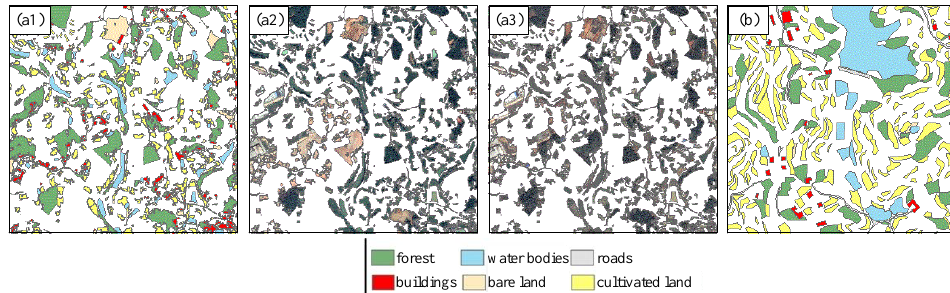
Figure 7. The result of sampling design: ( a1 , b ) are the sample objects for six types of surface objects from the vector map in the study area A and B, respectively; ( a2 , a3 ) are the sample image objects from the QuickBird images in 2017 and the aerial images in 2016 in the study area A, respectively.